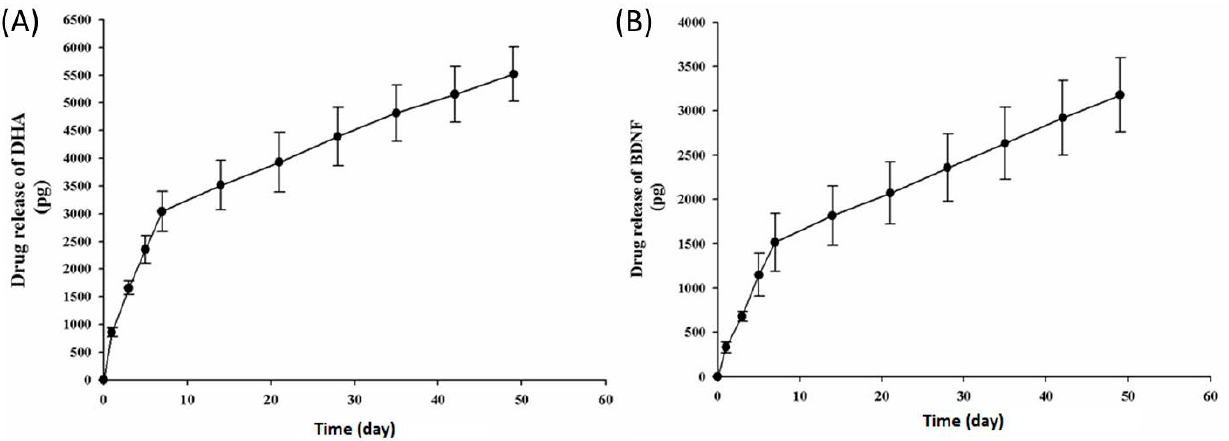
Figure 3. The cumulative weight of DHA ( A ), and BDNF ( B ) released from PLA/DHA/BDNF core–shell fibrous membranes (CSFMs).